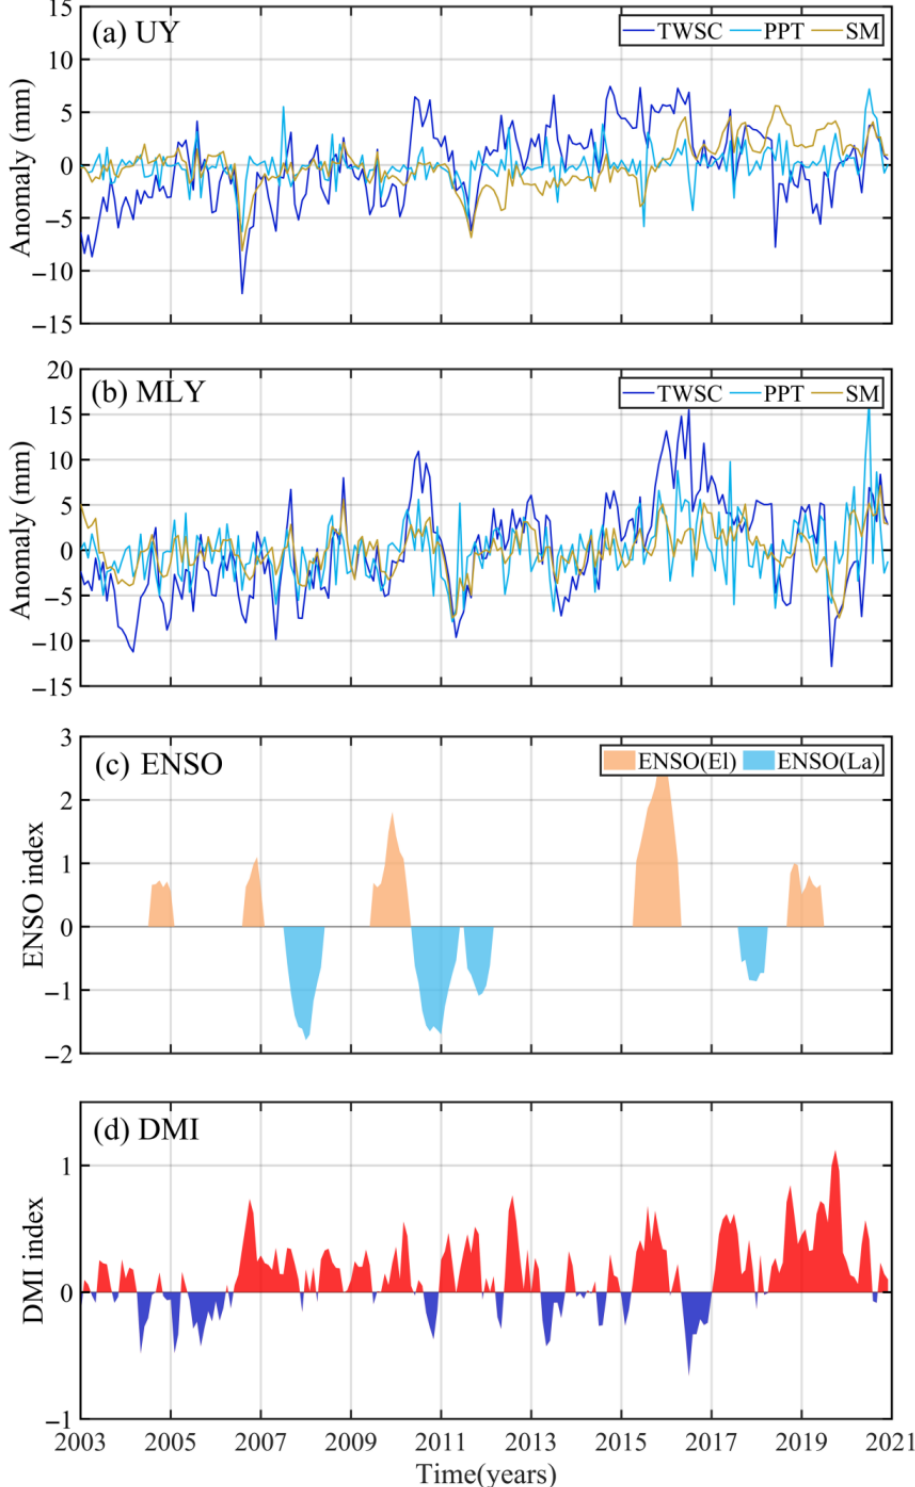
Figure 10. The time series of TWSC, PPT, ET, SM, and runoff anomaly in ( a ) the UY and ( b ) the MLY, ( c ) The temporal distribution of ENSO events, and ( d ) The time series of DMI during 2003~2020. In ( c ), orange shade: El Niño; blue shade: La Niña. Table 7. The drought and flood events statistics during and after ENSO events in the YRB.